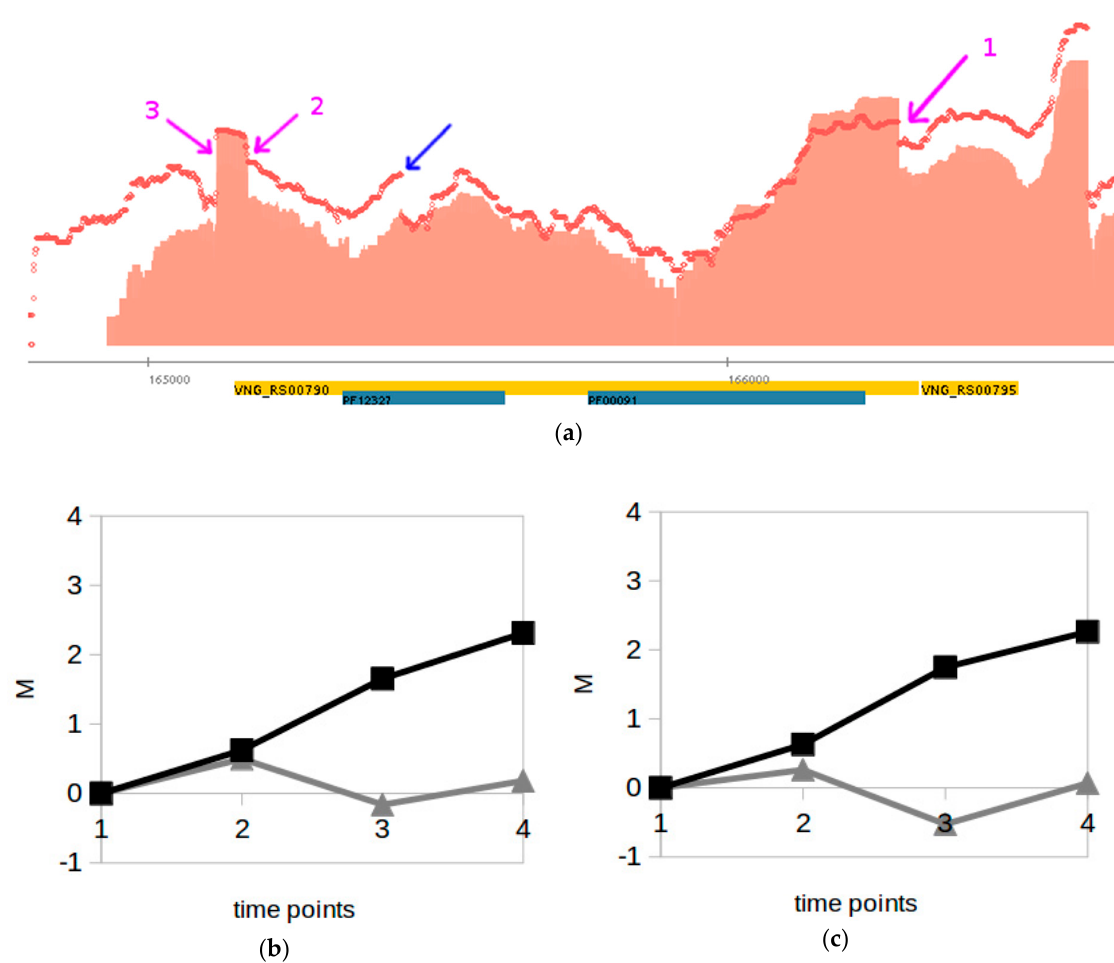
Figure 5. Example of differential processing during H. salinarum growth. ( a ) The conserved TPS (TPS_8657_1, arrow 1) is near the start codon inside the ftsZ2 gene (VNG_RS00790 locus ) which encodes a cell division protein. Pfam domain annotation (blue rectangles) and coding sequences are in reverse strand (orange rectangles), thus, 5 ′ → 3 ′ direction is right to left. Aligned reads coverage along genomic coordinates for TEX − libraries at exponential and stationary phases are shown in light red (solid) and red (dots), respectively (log 2 counts normalized and arbitrarily jointly scaled). Magenta arrows 2 and 3 point to non-conserved TPS and blue arrow points to intraRNA. ( b ) ftsZ2 gene log 2 fold-change (M) between multi-modality measurements in different time points relative to the early exponential phase from [35] (time point 1: early exponential, 2: mid exponential, 3: late exponential, 4: stationary, squares: RNA-seq data, triangles: Ribo-seq data). ( c ) Same as ( b ) but for cdrS (VNG_RS00795 locus ), encoding a ftsZ2 regulator.